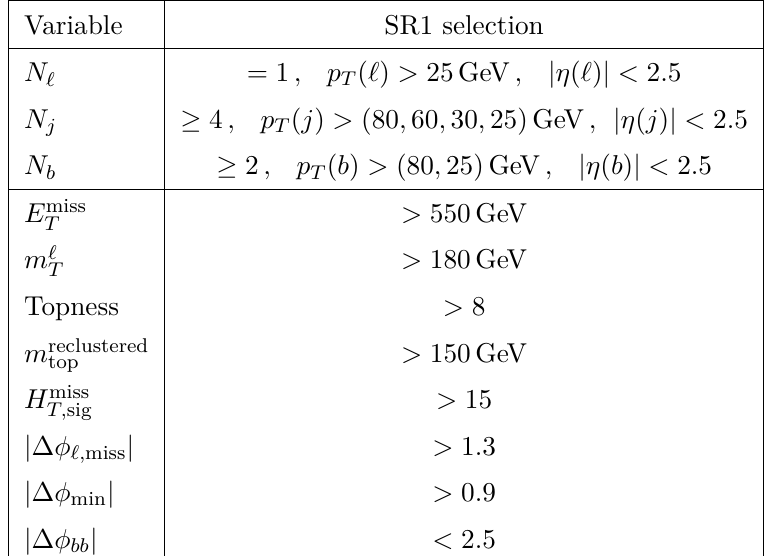
< 2 . 5 Table 1 . Definition of the signal region SR1. The number of charged leptons, light-flavoured jets and b -tagged jets are denoted by N ‘ , N j and N b , respectively. For further details consult the text. ‘ and ‘ and the jets j and j . The minimisation with respect to the jet pairs j and j 1 2 a a b b runs over all of the b -tagged jets if the number of b -tagged jets satisfies N ≥ 3 or over the b b -tagged jets and the untagged jet with the highest b -tagging weight if N ≤ 2 . Since the b three signal regions are designed to have no events in common, the final search